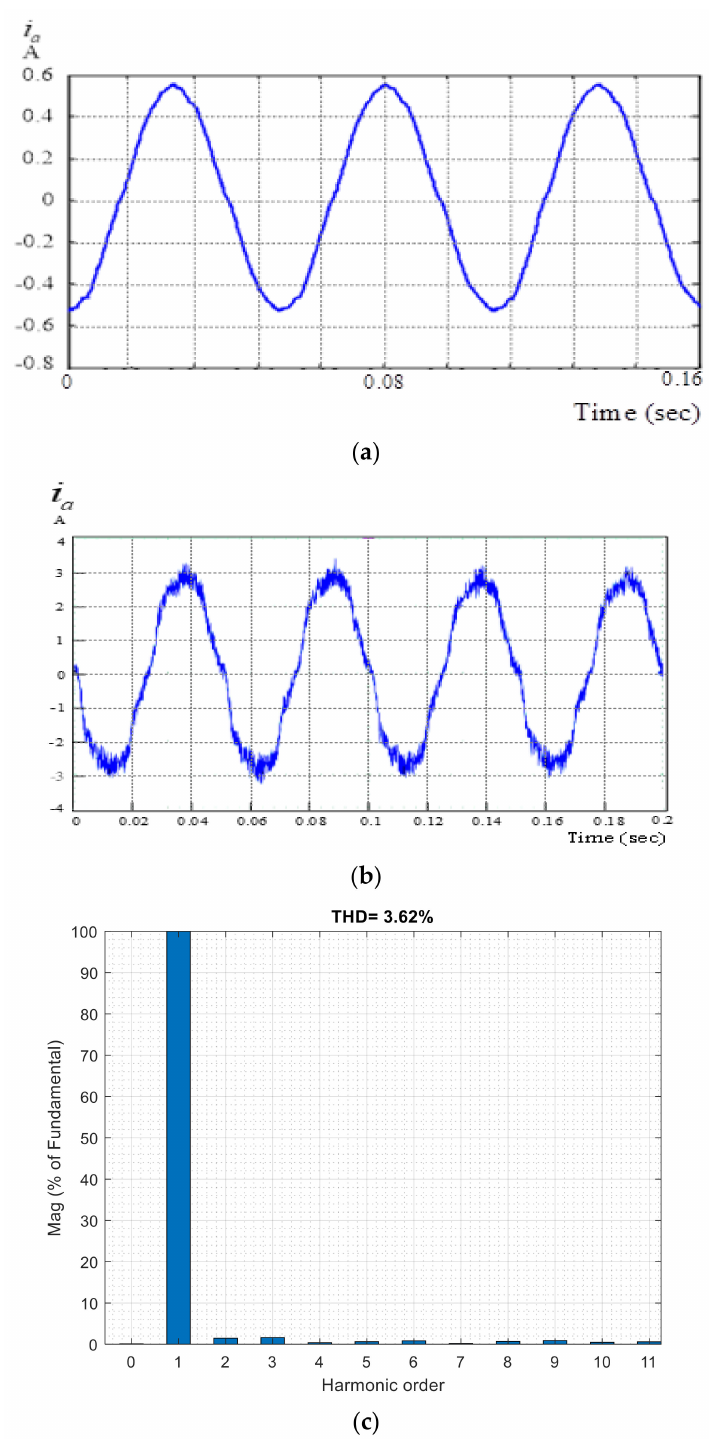
Figure 7. Phase currents. ( a ) Simulated; ( b ) measured; ( c )